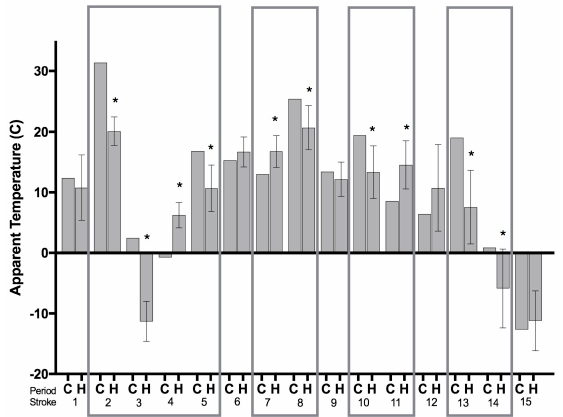
Figure 5. Mean apparent temperature (°C) in the control period (C) and the mean apparent temperature ±95% CI in the 7-day hazard periods (H) before the canine strokes (n = 15). Significant effects (* p < 0.05) are displayed within boxes.